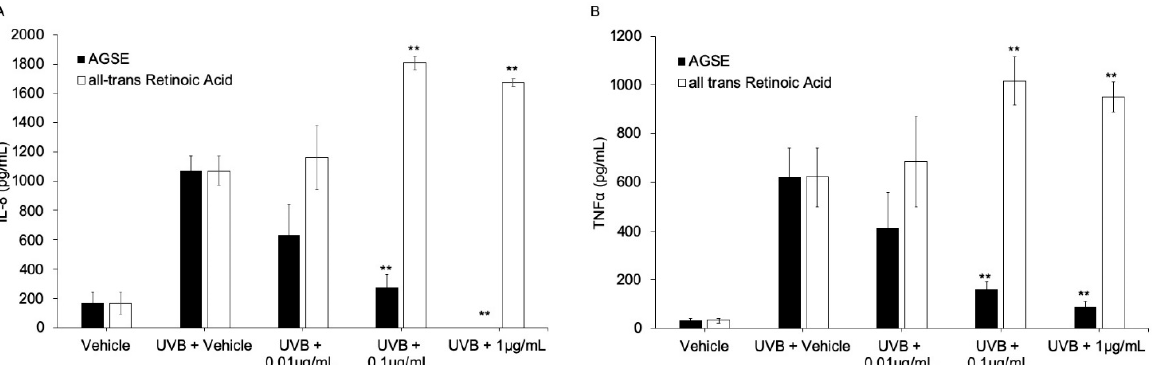
Figure 4. AGSE has anti-inflammatory activity blocking UVB-induced pro-inflammatory cytokine production. Primary Normal Human Epidermal Keratinocytes (NHEKs) were cultured in the presence of AGSE or ATRA ( all-trans retinoic acid) for 6 h. Later, test compounds were removed and the cells were irradiated with 25 mJ/cm 2 UVB. Media supernatants were collected after 24 h and analyzed by ELISA for ( A ) Interleukin-6 (IL-8) or ( B ) Tumor necrosis factor alpha (TNF α ). Data represents mean ± SE from three independent experiments. ** p ≤ 0.01 relative to that in UVB-vehicle irradiated